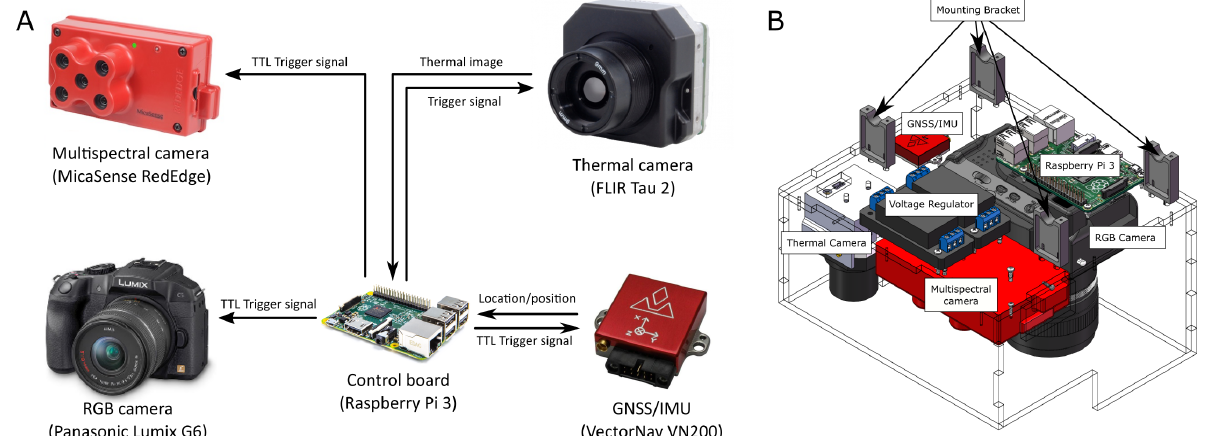
Figure 1. System diagram ( A ) and mechanical structure ( B ) of the first version of the data acquisition system.